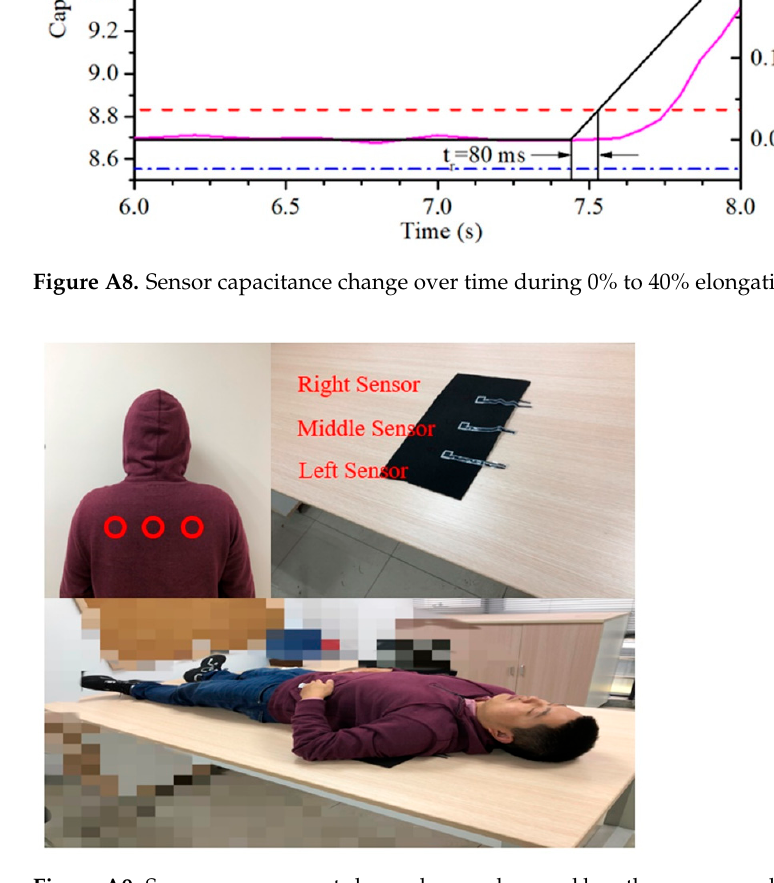
Figure A9. Sensor arrangement shows deep and normal breaths were recorded with the subject lying supine. The integrated sensor was placed under the back of the tester.